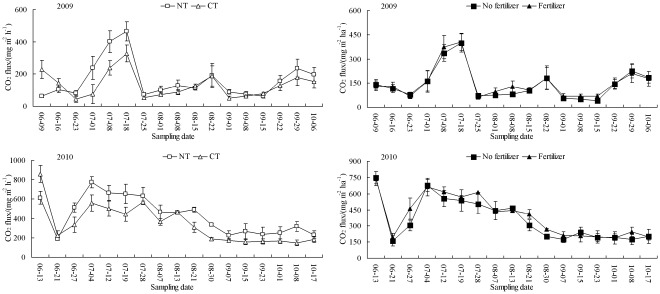
Changes in CO2 emission fluxes from paddy fields under different management practices during the 2009 and 2010 rice growing seasons.The vertical bars are standard deviations of the mean, n = 3.